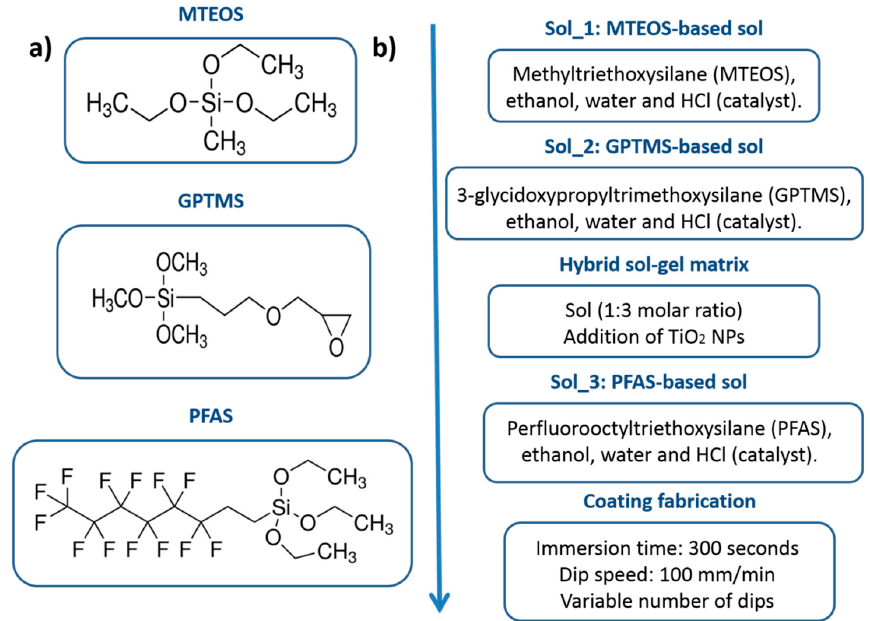
Figure 1. ( a ) Chemical structure of the sol-gel metal alkoxide precursors methyltriethoxysilane (MTEOS), 3-(Glycidyloxypropyl)trimethoxysilane (GPTMS), and 1H,1H,2H,2H- Perfluorooctyltriethoxysilane (PFAS). ( b ) Evolution of the different steps involved in the sol-gel process for the fabrication of the TiO 2 nanoparticles (NPs) doped sol-gel hybrid coatings with water-repellent